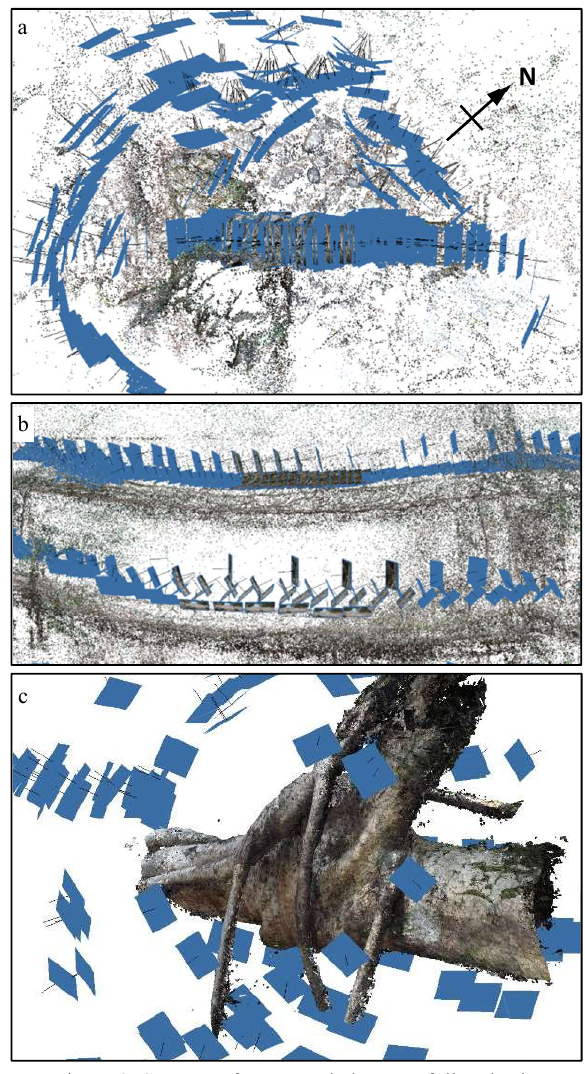
Figure 2: Surveys of LRBs and elements follow basic schema: a 360° survey of smaller bridges (a, Nongriat Access bridge); regular interval photography of the deck (b, Nongriat Double Decker) and spherical surveys for joints